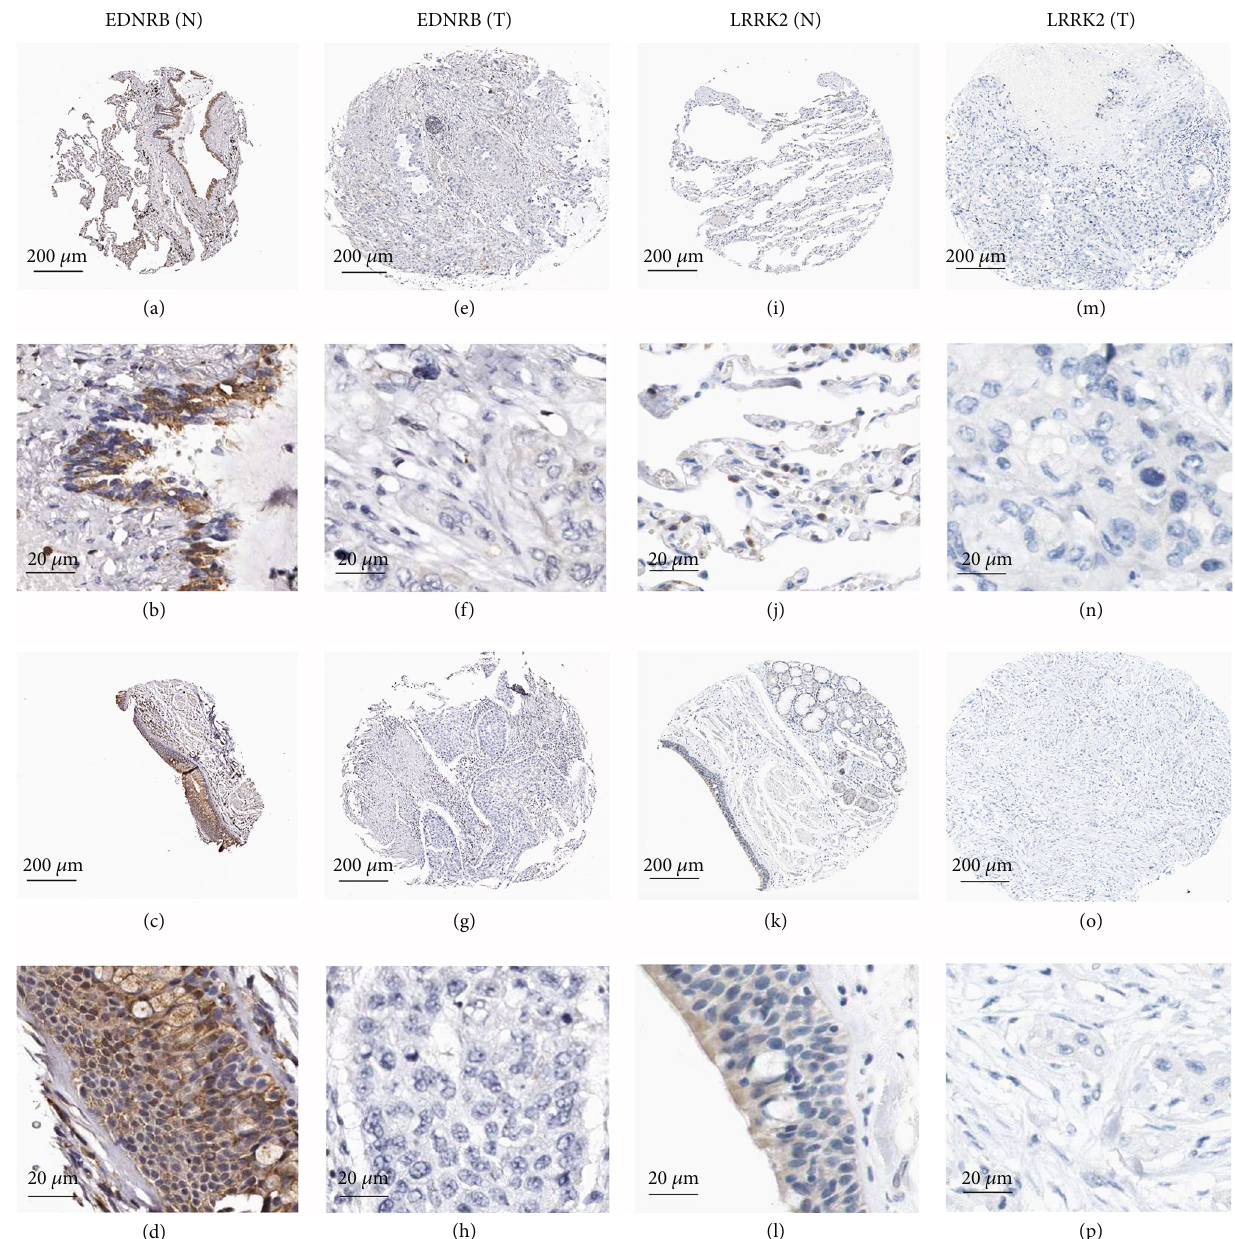
Figure 11: Protein expression of two prognosis-related hub genes in the normal lung and LUSC tissue based on The Human Protein Atlas database. (a, b) EDNRB protein expression level in normal lung was low (intensity: low, quantity: 25-50%, location: cytoplasmic/ membranous). Antibody HPA027546 was used. (c, d) EDNRB protein expression level in a normal bronchus tissue was moderate (intensity: moderate, quantity: 50-75%, location: cytoplasmic/membranous). Antibody HPA027546 was used. (e – h) EDNRB